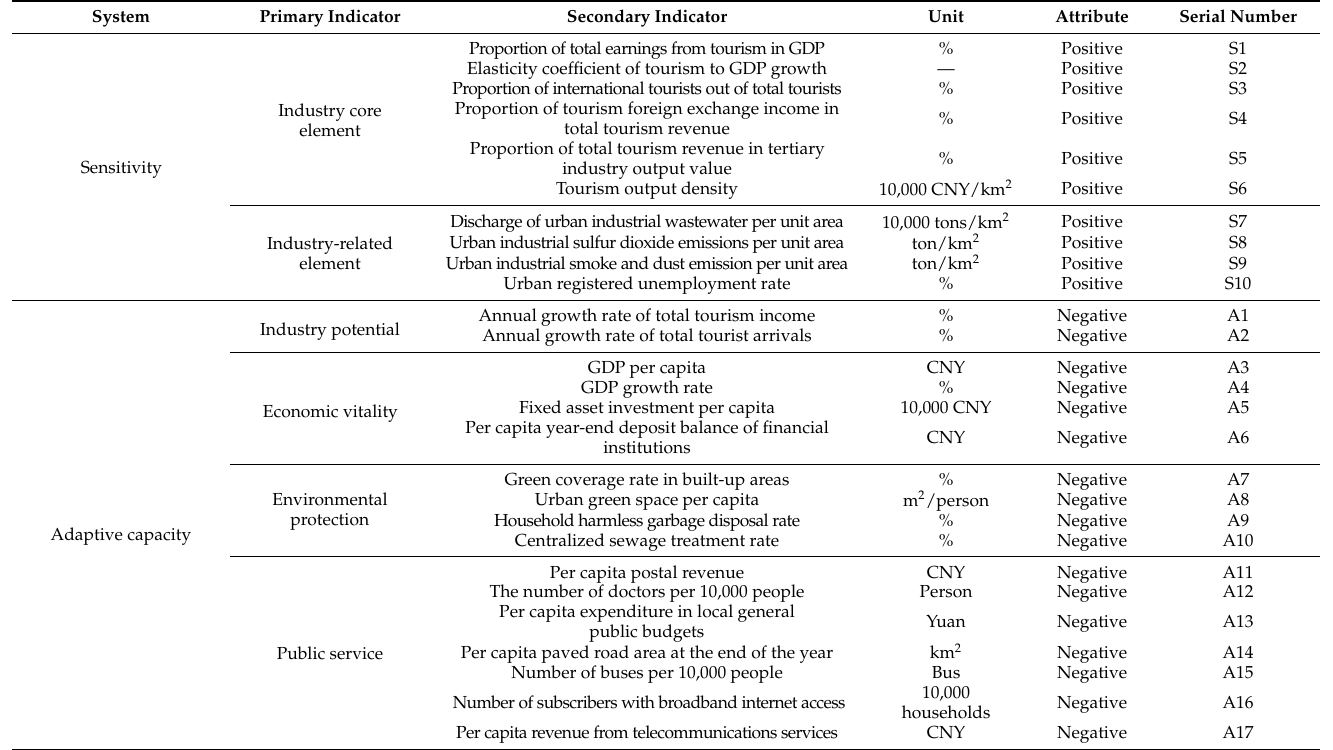
Table 1. Index system of